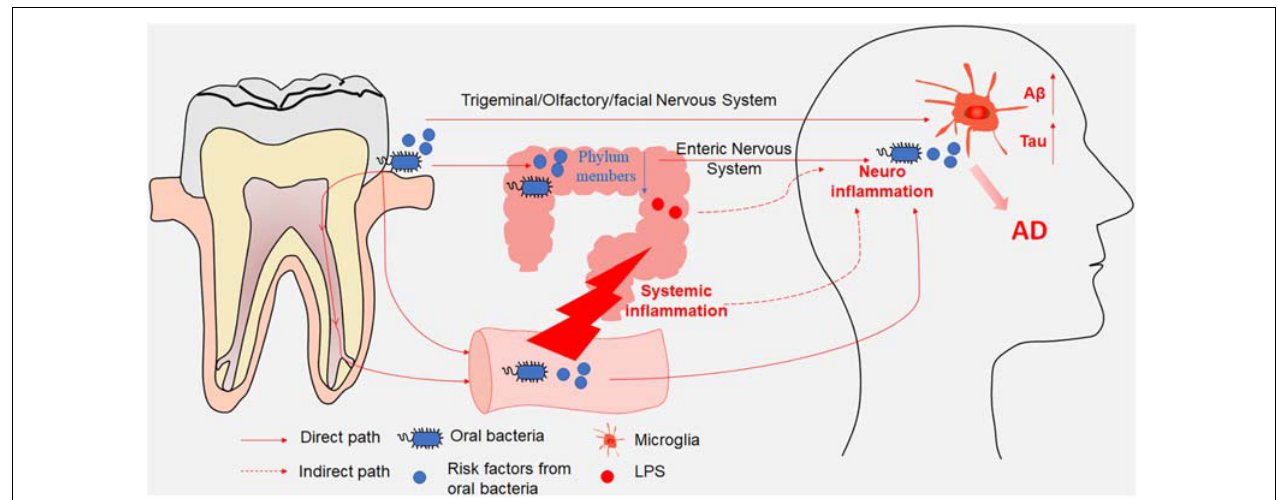
FIGURE 1 | A schematic illustration depicting the paths through which oral and intestinal microbiota enter the central nervous system (CNS). Oral bacterial species and their products affected the brain either directly through the trigeminal/olfactory/facial nervous system and circulating blood or indirectly through gut microbiota disturbance. Meanwhile, gut microbiota and their products affected the brain either directly through the enteric nervous system or indirectly through mediating systemic inflammation. Both direct and indirect effects from oral and intestinal microbiota contributed to the microglia-mediated neuroinflammation, resulting in AD-related